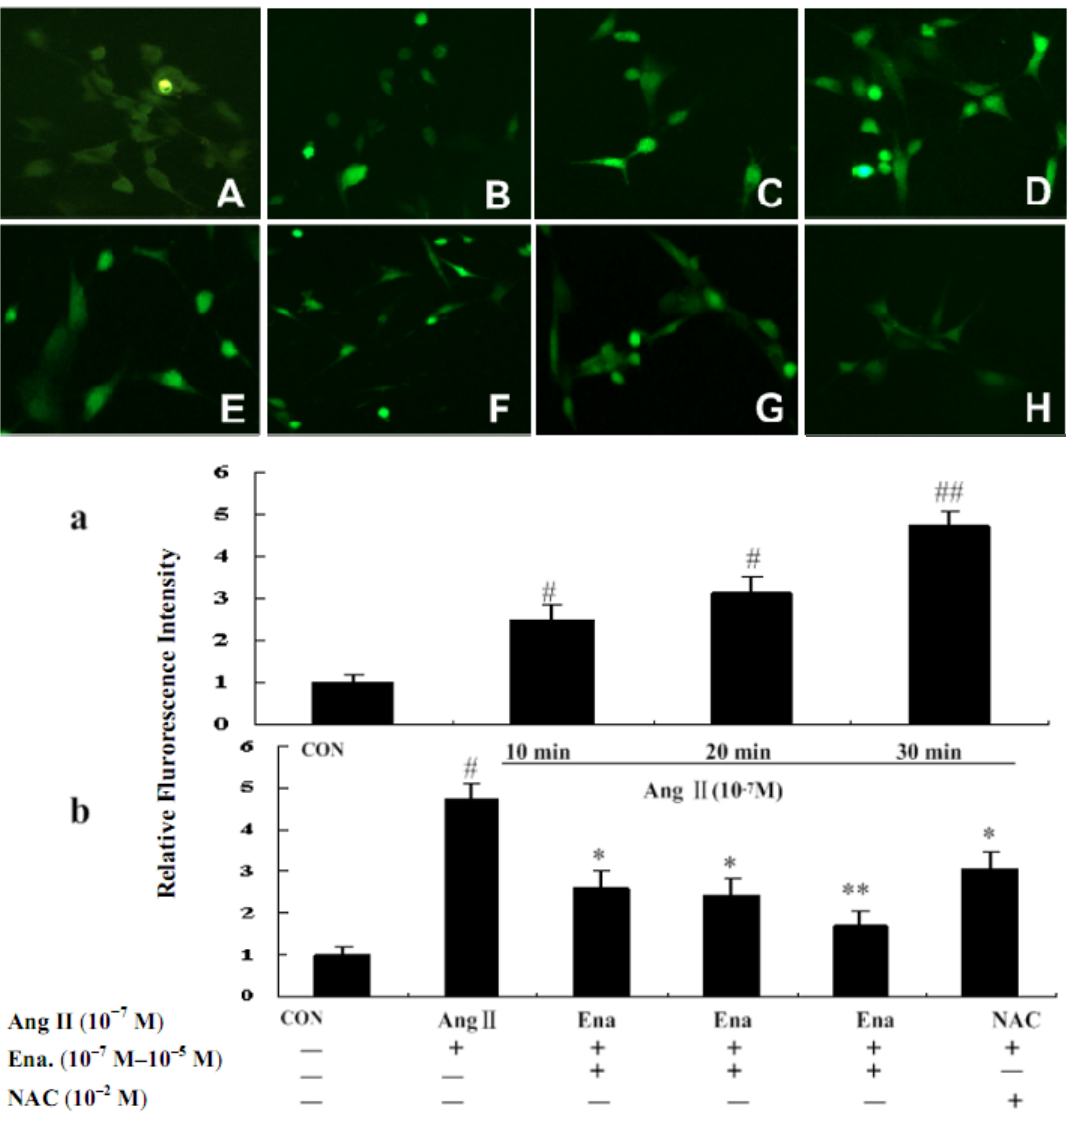
Figure 2. Effects of Ena. and antioxidant NAC on ROS intensity of cardiac fibroblasts in fluorescence microscope (200×). CFb were cultured in Dulbecco’s Modified Eagle Medium containing Ang II (10 − 7 M) for 10 minutes, 20 minutes and 30 minutes, and treated with enalaprilat (10 − 7 M, 10 − 6 M, and 10 − 5 M) for 30 minutes. CFb were labeled with 2',7'-dichlorofluorescein diacetate for 30 minutes and ROS generation was analyzed by fluorescence detection with fluorescent microscopy at 200×. Upper part: A : CFb were cultured in Dulbecco’s Modified Eagle Medium without Ang II; B : CFb were stimulated with Ang II for 10 min; C : CFb were stimulated with Ang II for 20 min; D : CFb were stimulated with Ang II for 30 minutes; E – G : CFb were stimulated with Ang II and treated with Ena. (10 –7 M, 10 –6 M, and 10 –5 M respectively) for 30 minutes; H : CFb were stimulated with Ang II and treated with NAC (10 –2 M, 30 minutes prior to Ang II administration) for 30 minutes. Lower part: a and b : Statistic representations are indicated as bars in involved group. Data are presented as mean ± S.E.M. # P < 0.05, ## P < 0.01 vs. control; * P < 0.05, ** P < 0.01 vs. Ang II